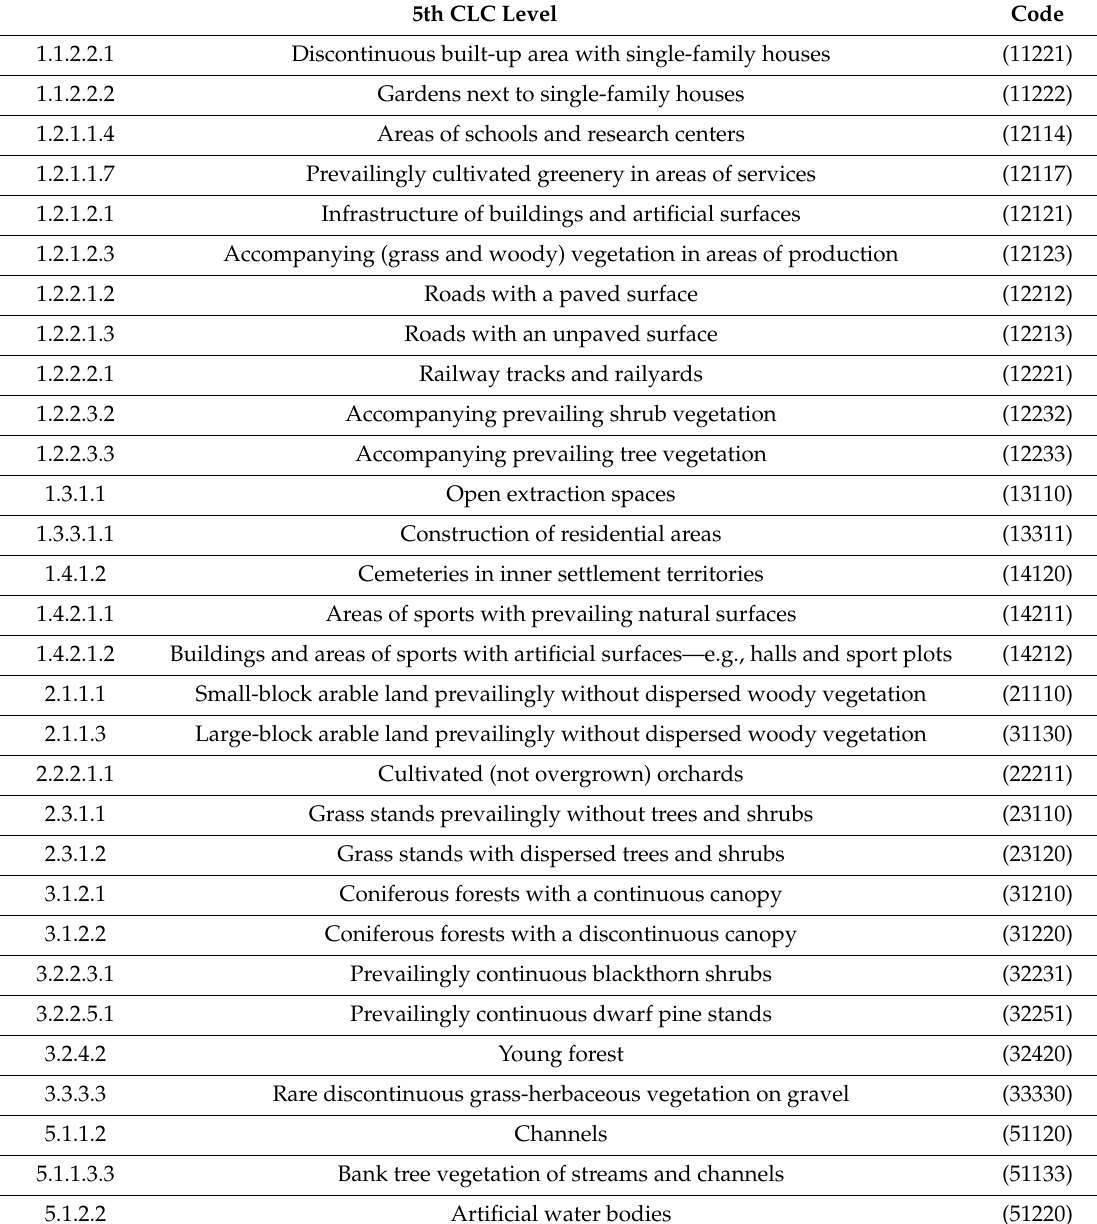
Table 5. Legend of Land Cover Codes in Figure 5